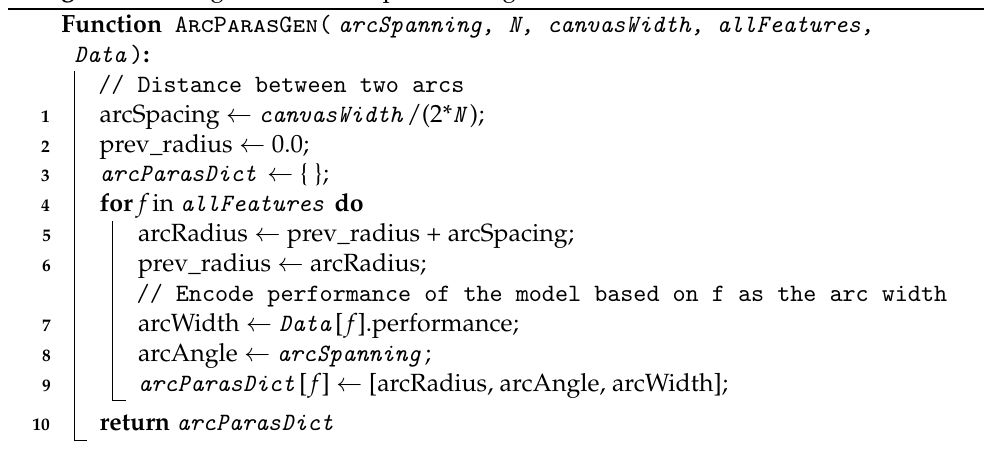
Algorithm 1: Algorithm for arc parameter